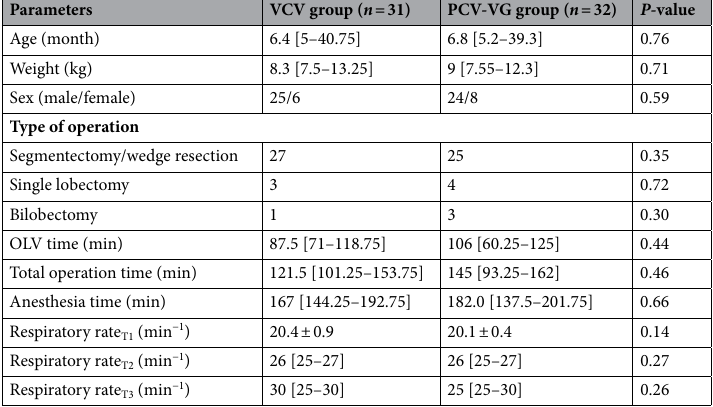
Table 1. Baseline characteristics. All data are presented as mean ± SD or median [IQR], unless otherwise specified. VCV volume controlled ventilation, PCV-VG pressure controlled volume guarantee ventilation, OLV one lung ventilation.